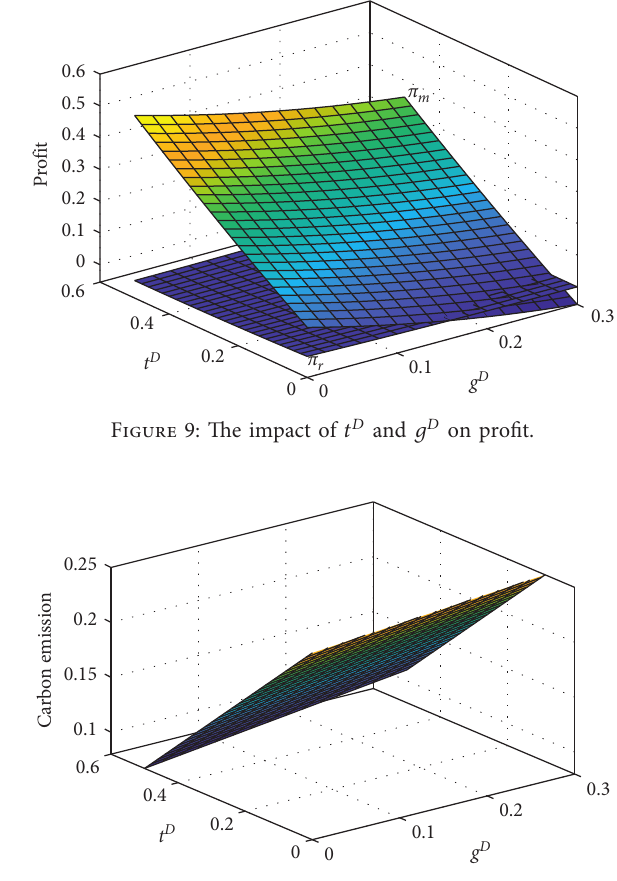
Figure 10: The impact of t D and g D on carbon emission.